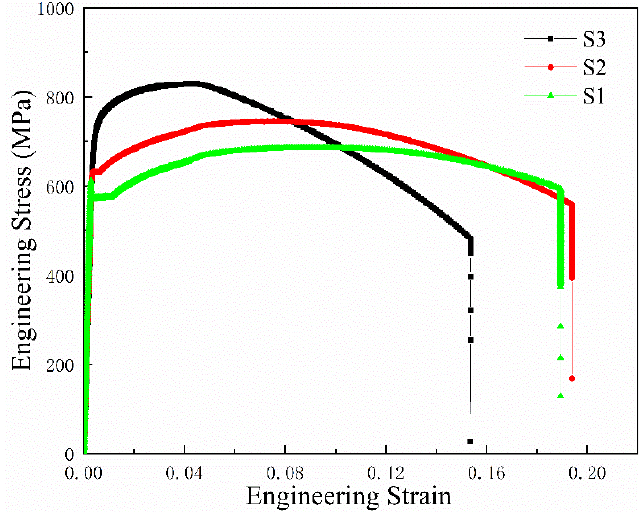
Figure 4. Tensile engineering stress–strain curves.